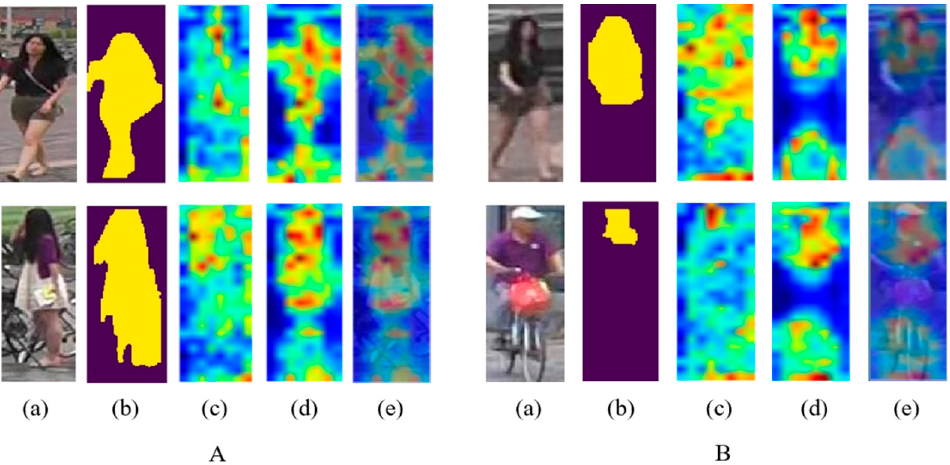
Figure 4. Comparison of saliency maps between different methods. Group A denotes images with relatively complete masks, while group B are with incomplete masks. In both A and B, ( a ) and ( b ) are input RGB images and masks through segmentation. ( c ) to ( e ) are: Saliency maps from traditional baseline method, saliency maps from our method with a dynamic part-attention branch, and overlay results between ( a ) and ( d ) for better visualization. Best viewed on a color screen.